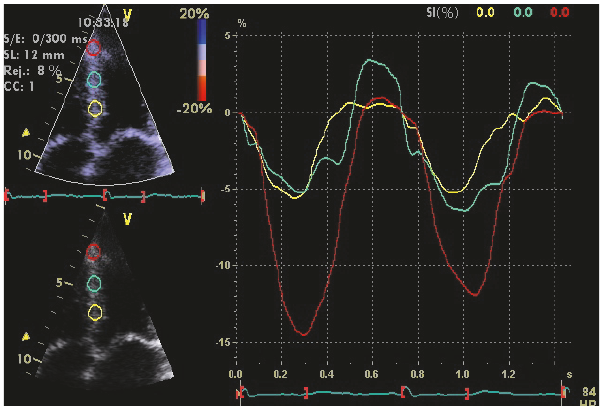
Figure 4: Strain curves from the interventricular septum of the same patient appearing in Figures 2 and 3. In this example, strain curves were constructed with the Doppler Myocardial Imaging technique. There is reduced peak systolic strain of the basal (yellow curve) and mid (green curve) septal segments, compared to the apical segment (red curve) with an apex to base ratio >